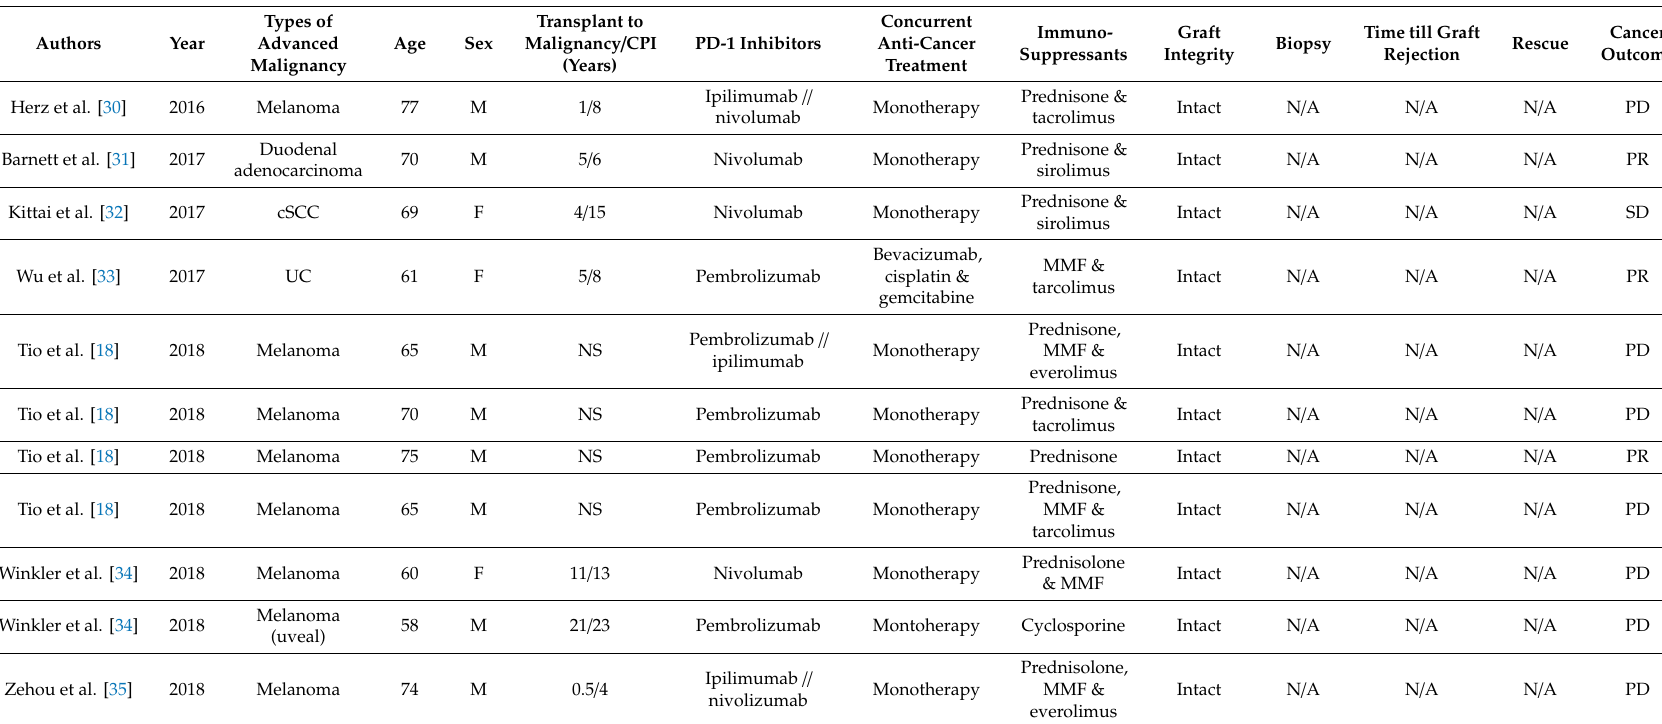
Table 2. Clinical response and intact graft after PD-1 inhibitors in various advanced malignancies of renal transplant